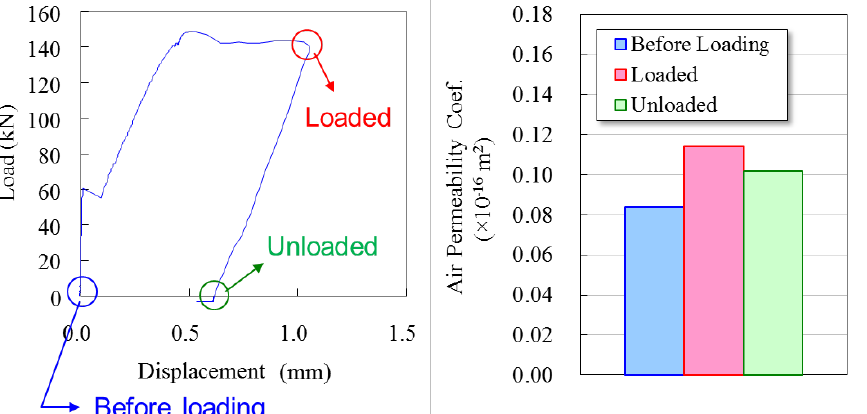
Figure 5. Difference in the air permeability coefficient between loading and unloaded